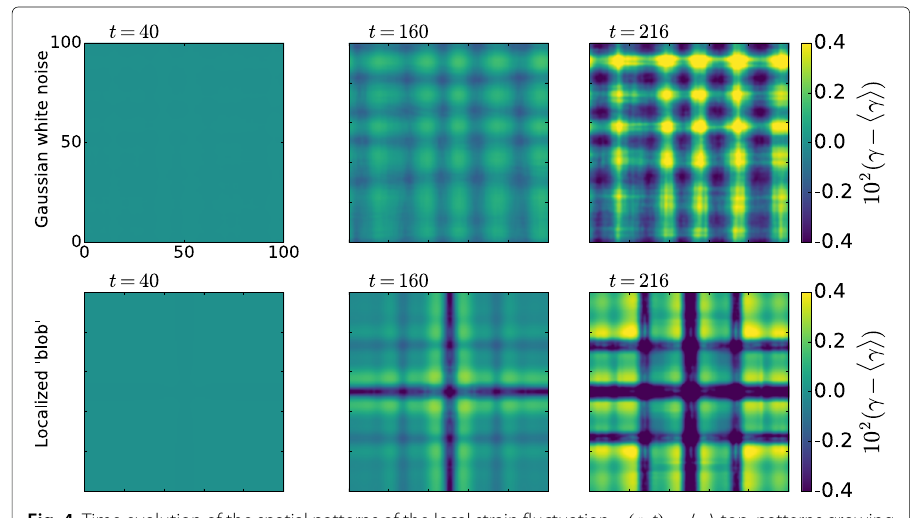
Fig. 4 Time evolution of the spatial patterns of the local strain fluctuation γ( r , t ) − (cid:14) γ (cid:15) top: patterns growing from uncorrelated Gaussian noise (initial condition (i)), bottom: patterns growing from a single localized perturbation (initial condition (ii)); parameters as in Fig. 3